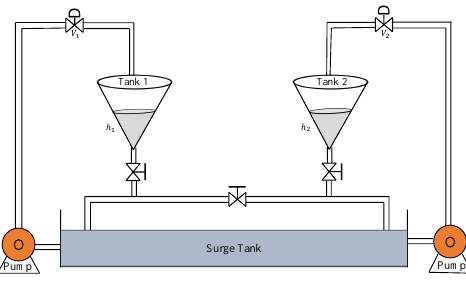
Figure 6. Coupled conical tank